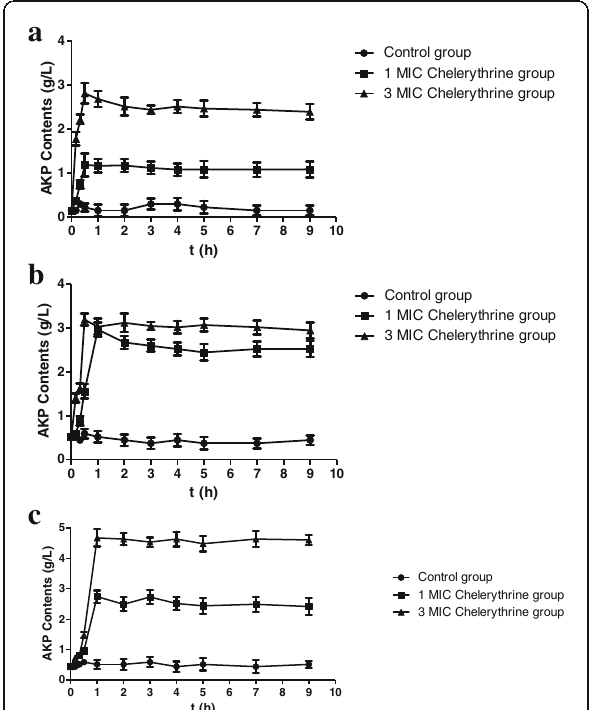
Fig. 2 The extracellular activities of AKP against SA ( a ), MRSA ( b ) and ESBLs-SA ( c )